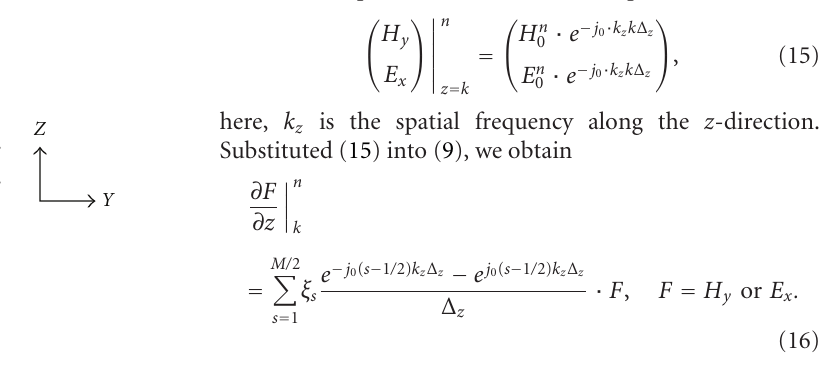
Figure 2: Subcell technique specifies for the Ex field calculation in (4, M )